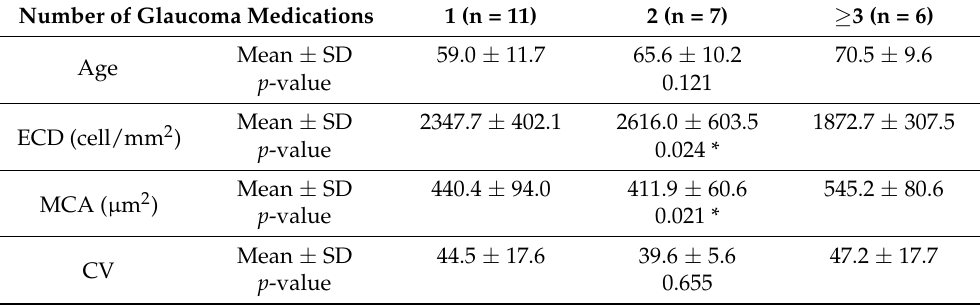
Table 3. ANOVA Models: CEC parameters stratified by number of glaucoma medications. Number of Glaucoma Medications